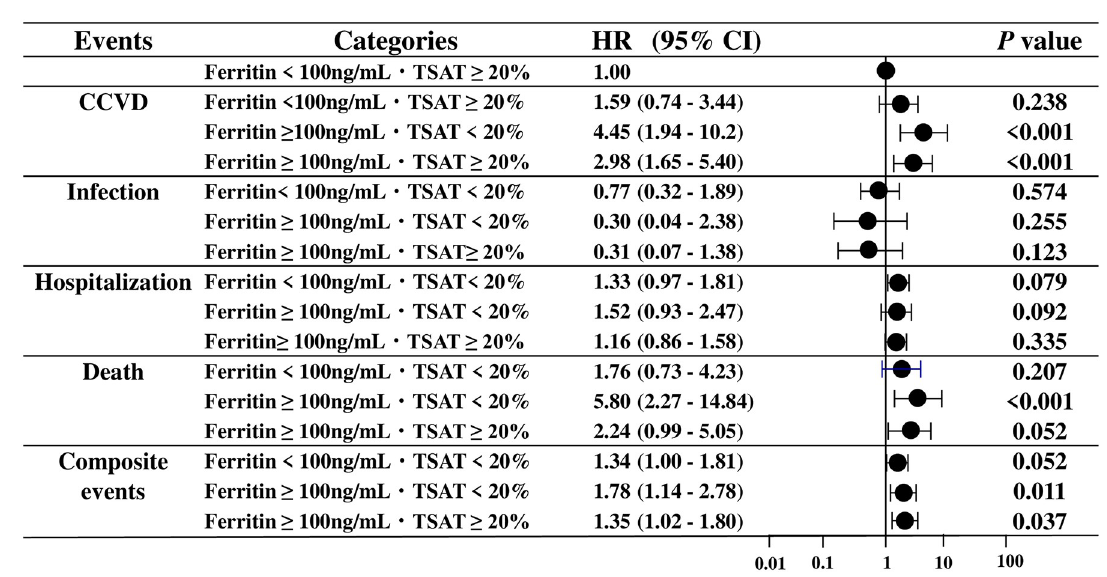
Fig 5. The relationship between ferritin levels, TSAT categories, and adverse events. CCVD: cerebrovascular and cardiovascular disease. Composite events: CCVD, infection, hospitalization, and death.